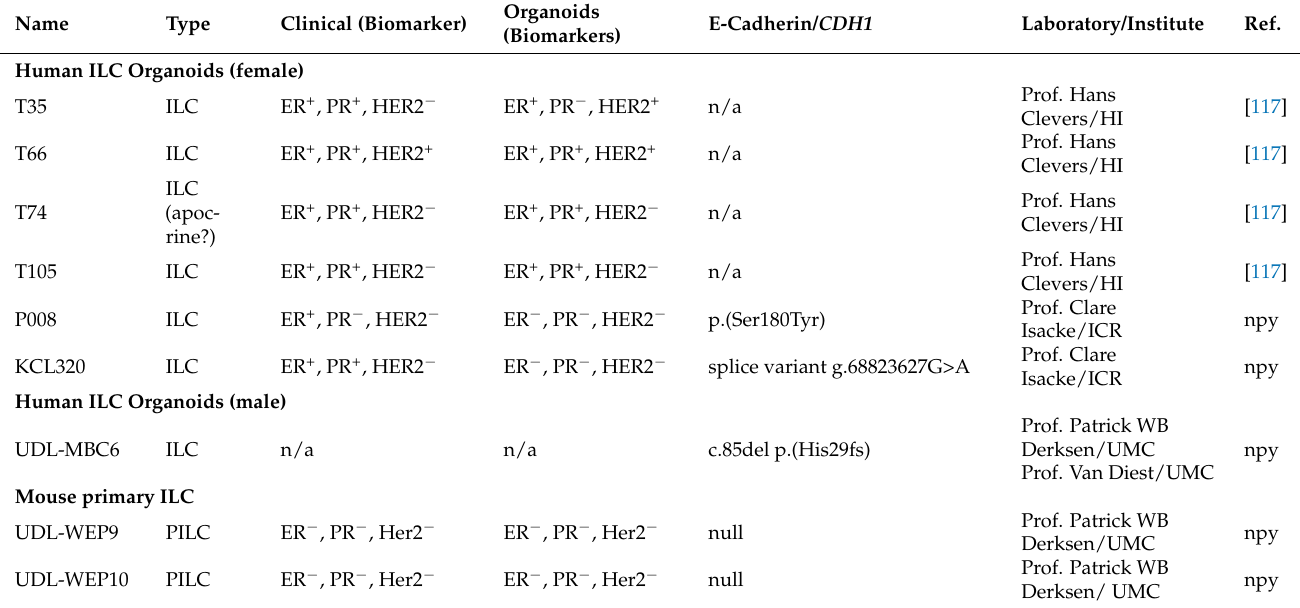
Table 3. ILC Patient-Derived Organoids. Expanded table at Supplemental File S1. Abbreviations: HI, Hubrecht Institute; ICR, The Institute of Cancer Research; UMC, University Medical Center Utrecht; UDL = UMCU Derksen Lab; PILC, pleomorphic ILC; Ref, reference(s); n/a, not available; npy, not published